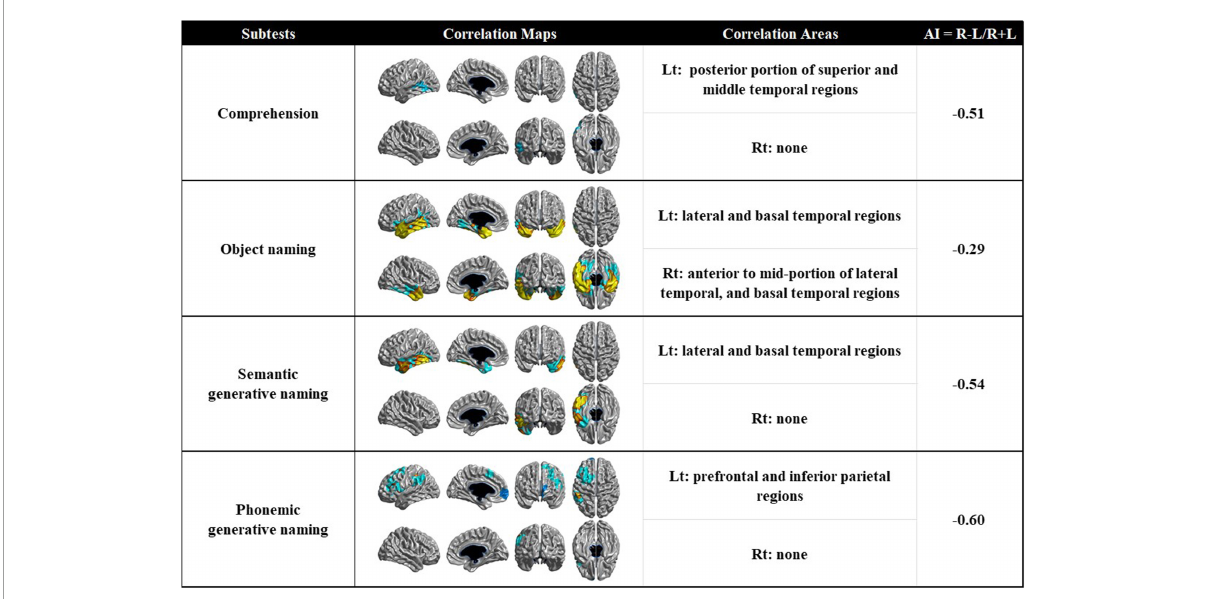
FIGURE2 Correlation maps demonstrating the association between cortical thickness and language function tests in patients with PPA (AI > 0 means right-sided correlated areas > left-sided correlated areas, and vice versa for AI < 0). AI, asymmetric index; Rt, right; Lt,